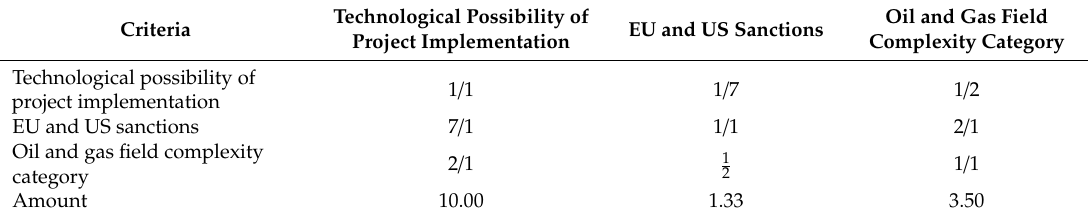
Table A3. Results of assessment of relative importance of technological sustainability criteria.